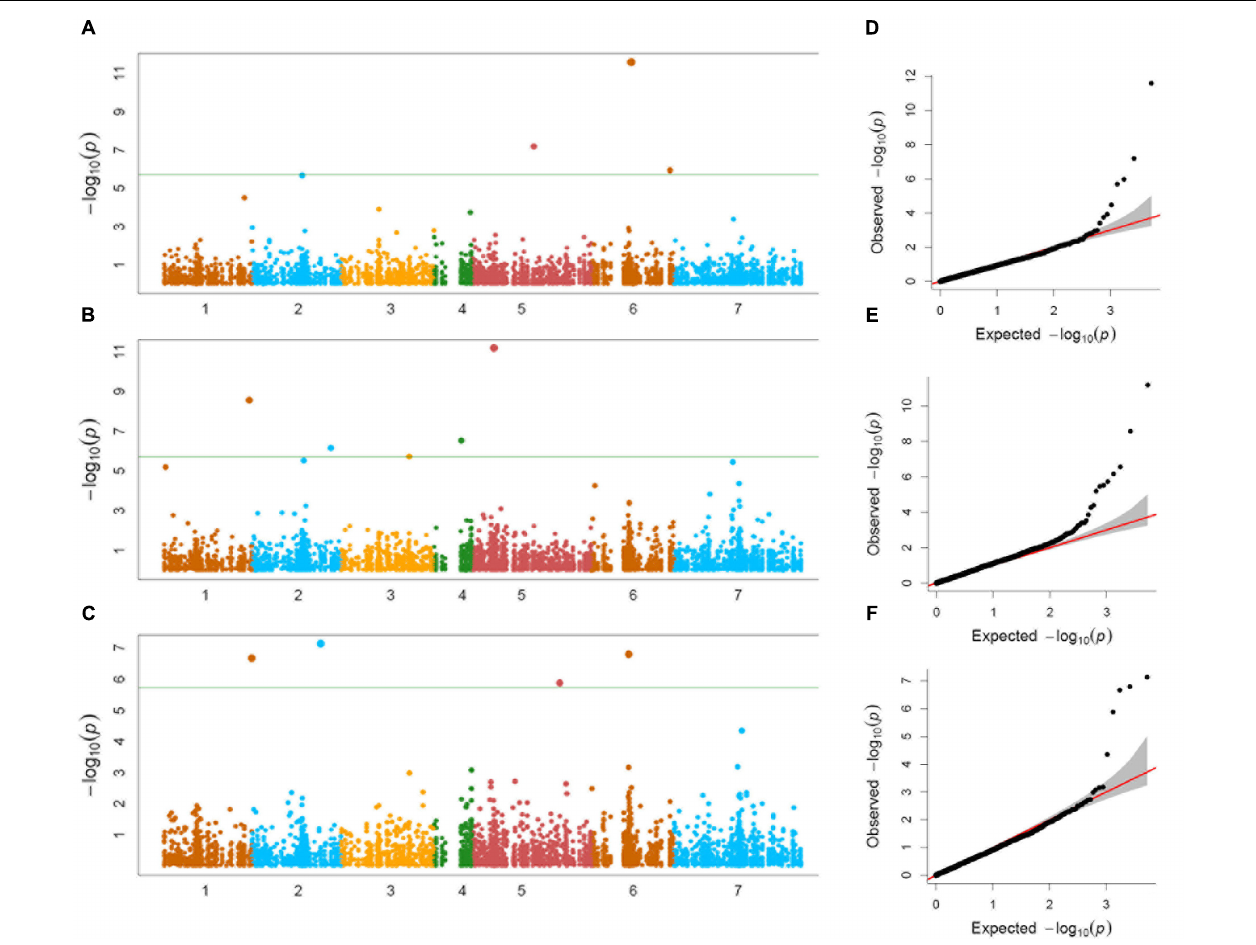
FIGURE 5 | (A–C) Manhattan plots of (A) grain length, (B) grain width, and (C) grain weight for the seven chromosomes carrying the significant markers detected by MLM models using BLUP values; (D–F) Quantile–Quantile (Q–Q) plots for (D) grain length, (E) grain width, and (F) grain weight showing expected null distribution of p -values, assuming no associations, represented as solid red line; distribution of p -values